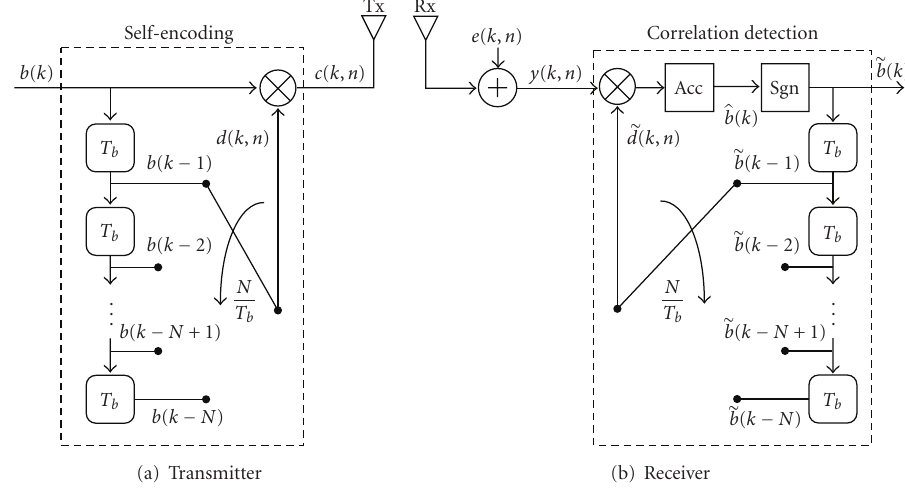
Figure 1: Block diagram of SESS